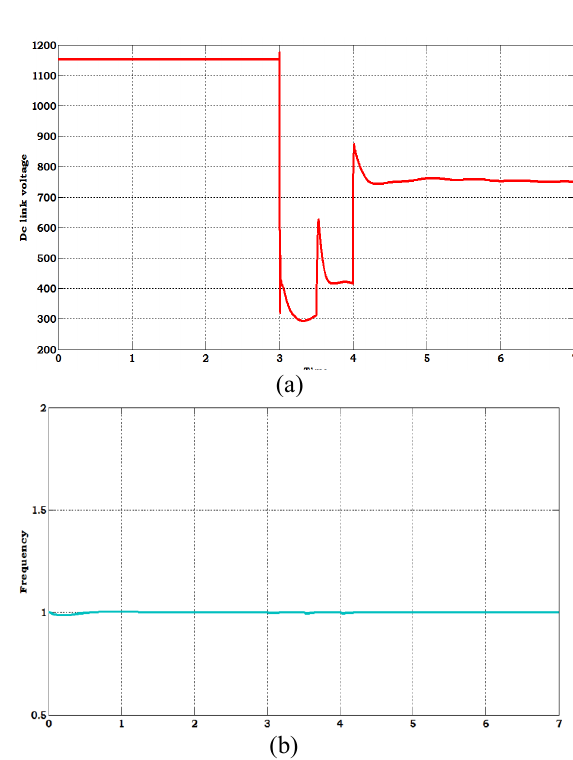
Figure 23. (a). DC link voltage, (b).Frequency Test Case 2: When operating system in grid connected mode with sudden disconnection of battery